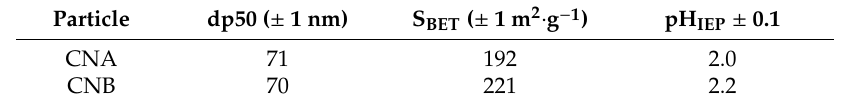
Table 5. Nanoparticle mean particle size (dp 50 ) measured by the dynamic light scattering (DLS)